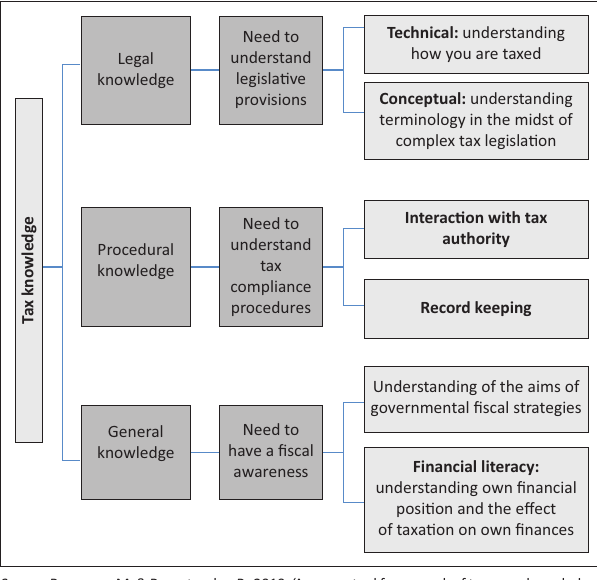
FIGURE 1: A conceptual framework of tax